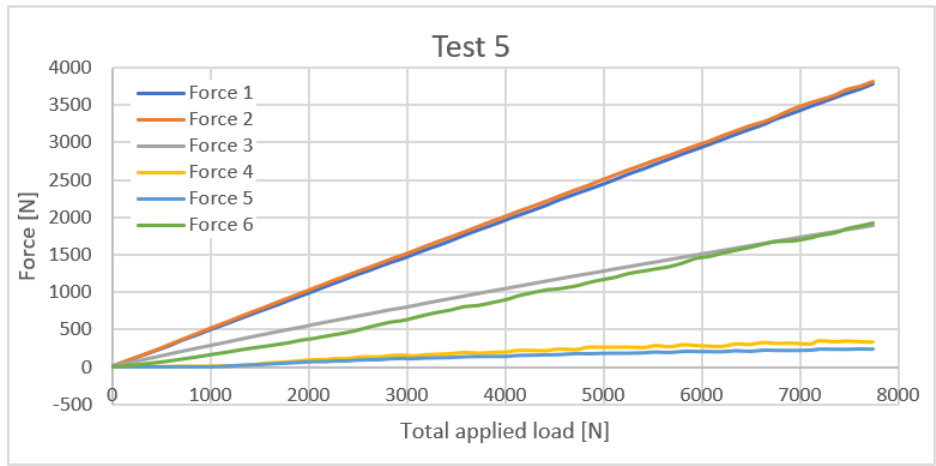
Figure 15. Total force redistribution into individual load cells during test five.